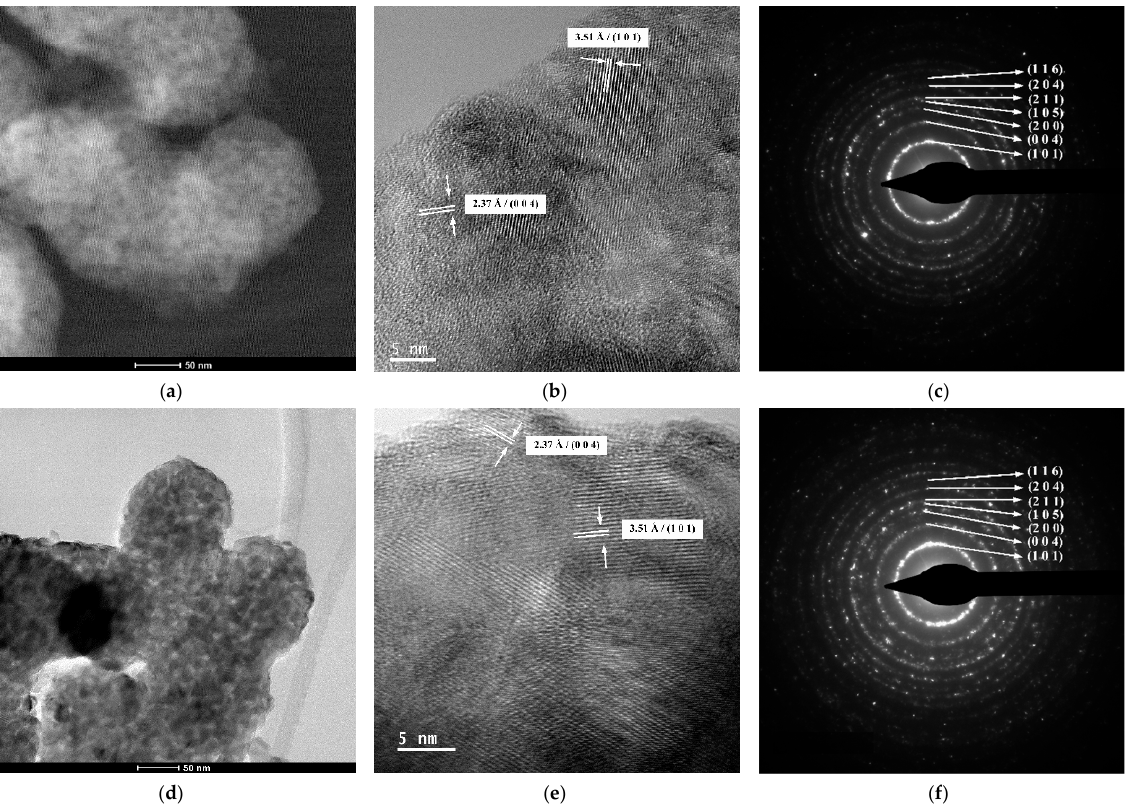
Figure 9. TEM images ( a , d ), HRTEM images ( b , e ), and SAED patterns ( c , f ) of the thermally treated samples: TiO 2 − Cu 2.0% MW ( a – c ) and TiO 2 − Zn 2.0% MW ( d – f ).